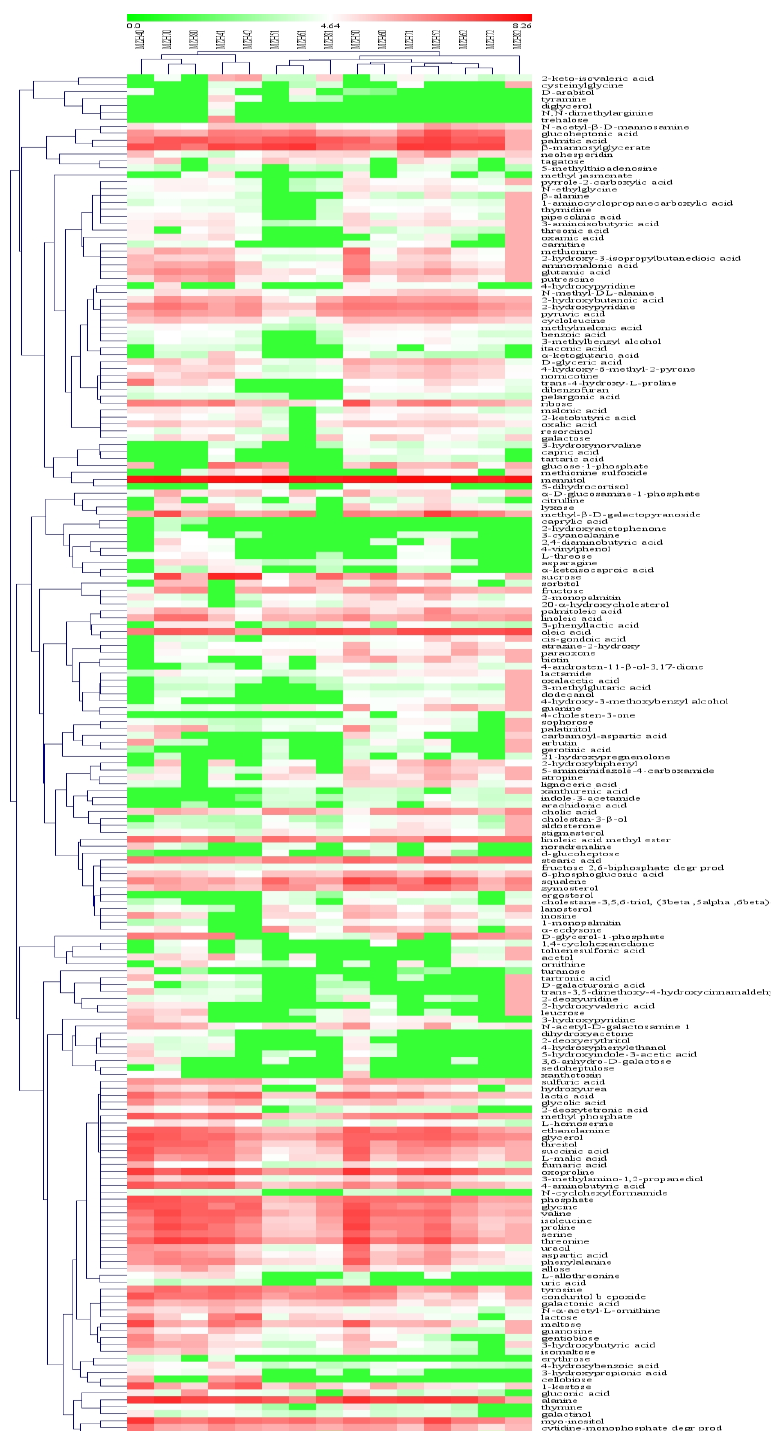
Figure 5. Heatmap and hierarchical cluster analysis for the 197 metabolites found in the mycelia of Epichloë sinensis . MZH40, MZH41 and MZH42 represent mycelia grown for 4 weeks in the presence of 0, 0.1, or 0.2 mmol/L Na 2 SeO 3 , respectively. MZH50, MZH51 and MZH52 represent mycelia grown for 5 weeks in the presence of 0, 0.1, or 0.2 mmol/L Na 2 SeO 3 , respectively. MZH60, MZH61 and MZH62 represent mycelia grown for 6 weeks in the presence of 0, 0.1, or 0.2 mmol/L Na 2 SeO 3 , respectively. MZH70, MZH71 and MZH72 represent mycelia grown for 7 weeks in the presence of 0, 0.1, or 0.2 mmol/L Na 2 SeO 3 , respectively. MZH80, MZH81 and MZH82 represent mycelia grown for 8 weeks in the presence of 0, 0.1, or 0.2 mmol/L Na 2 SeO 3 ,